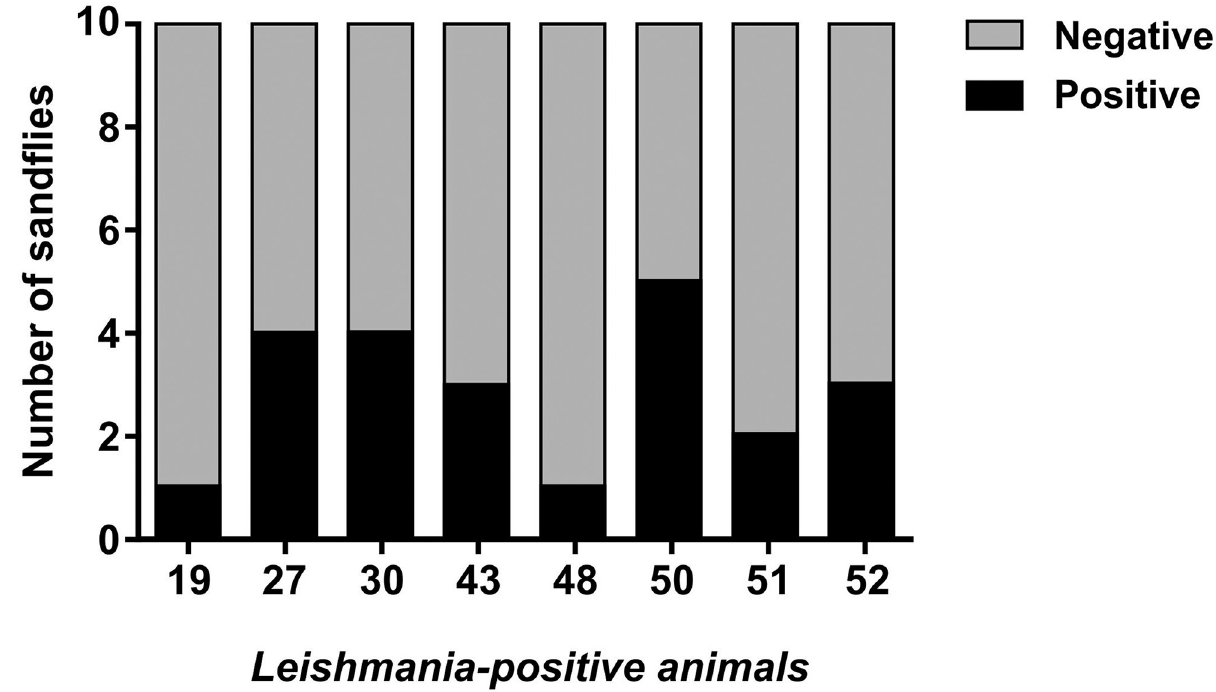
Fig 1. Transmission of Leishmania infantum from non-human primates to Lutzomyia longipalpis . Ratio of positive and negative sand flies (n = 10) exposed to each of the positive animals, and tested for detection L . infantum DNA by qPCR.